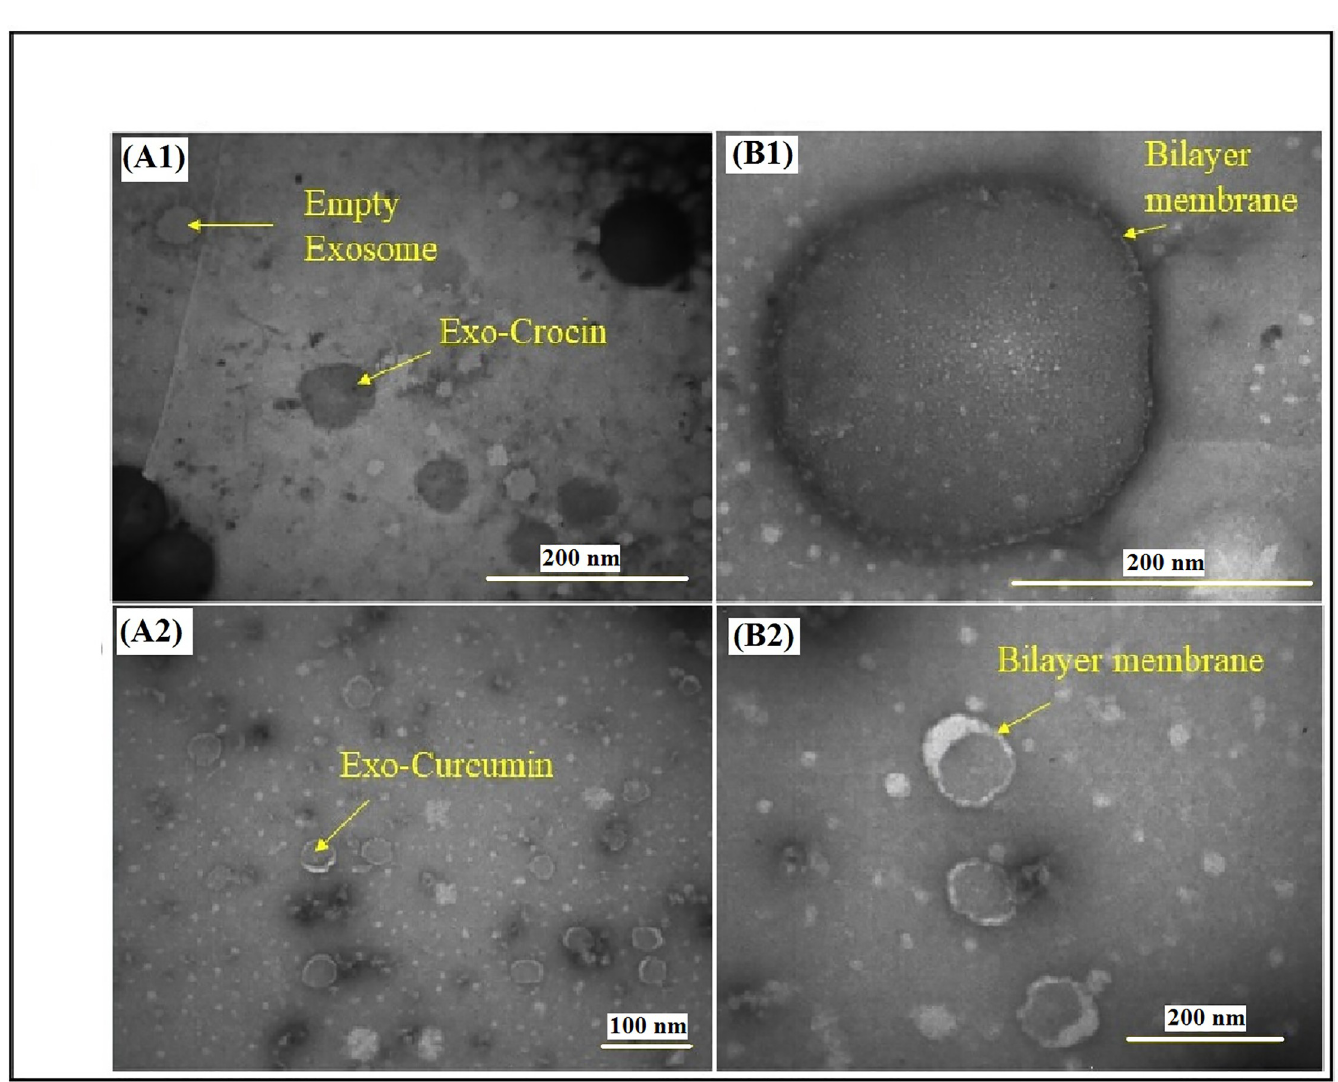
Fig 3. Characterization of ExoCrocin and ExoCurcumin using TEM images: An increased size, and color change to dark gray could be observed for ExoCrocin (A1); The inside of the exosomes is dark after curcumin loading, but no significant change in size (A2); Lipid membrane and integrity of exosomes after crocin (B1) and curcumin (B2) loading is clearly